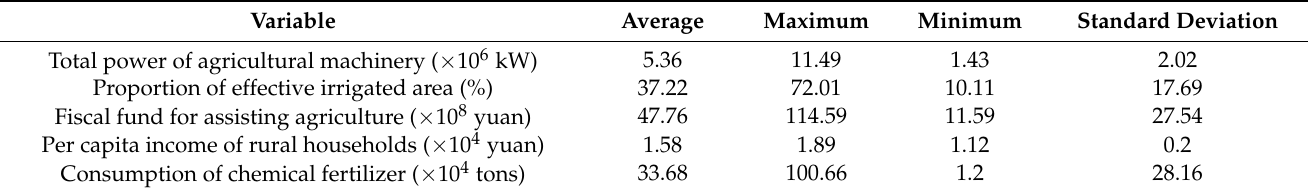
Table 2. Statistical description and expected impact of indicators of factors influencing maize